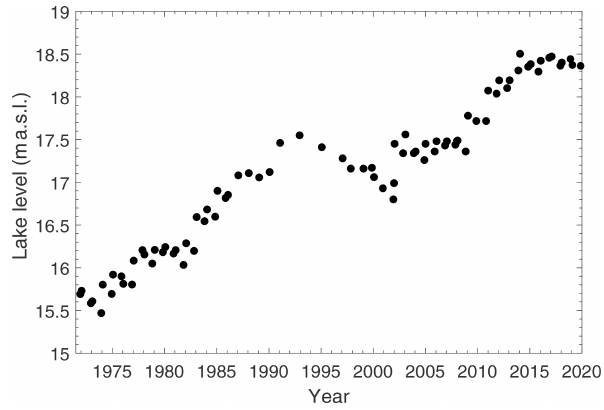
Figure 5. Lake level elevation in meters above sea level